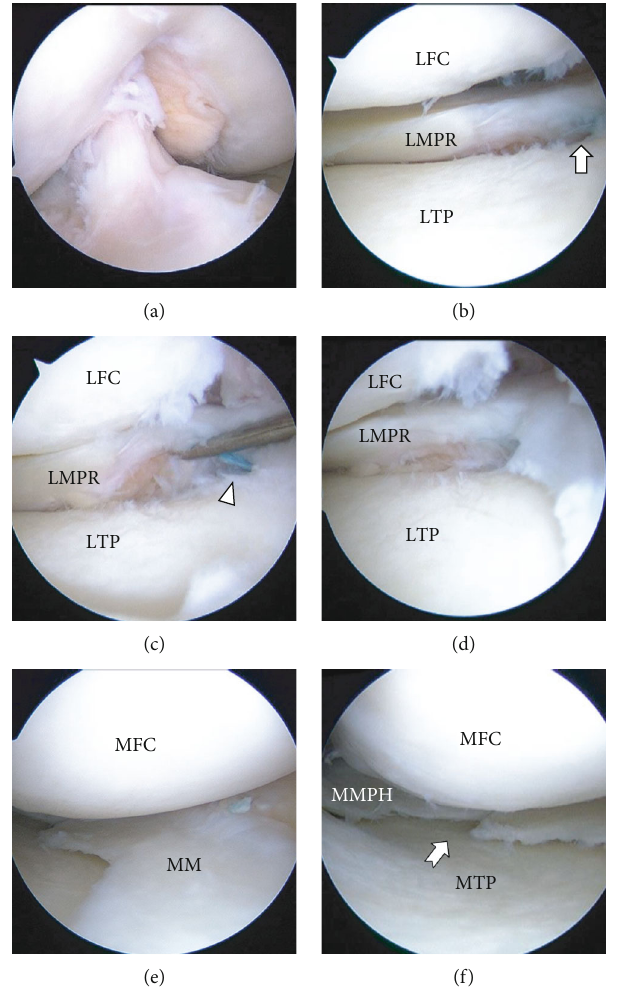
Figure 4: Arthroscopic fi ndings during the second-look arthroscopy. (a) Reconstructed ACL. (b) The repaired LMPR healed with continuity to its insertion site (arrow). (c) The repair sutures were cut out (arrowhead). (d) The synovial coverage around the root attachment. (e) The repaired MM bucket handle tear completely healed. (f) An approximately 1cm defect remained at the central margin of the repaired radial tear (swallow-tail arrow). Table 1: Clinical and radiographic fi ndings recorded preoperatively and at fi nal follow-up (2 years after the fi rst operation). Preoperative Final follow-up Lysholm